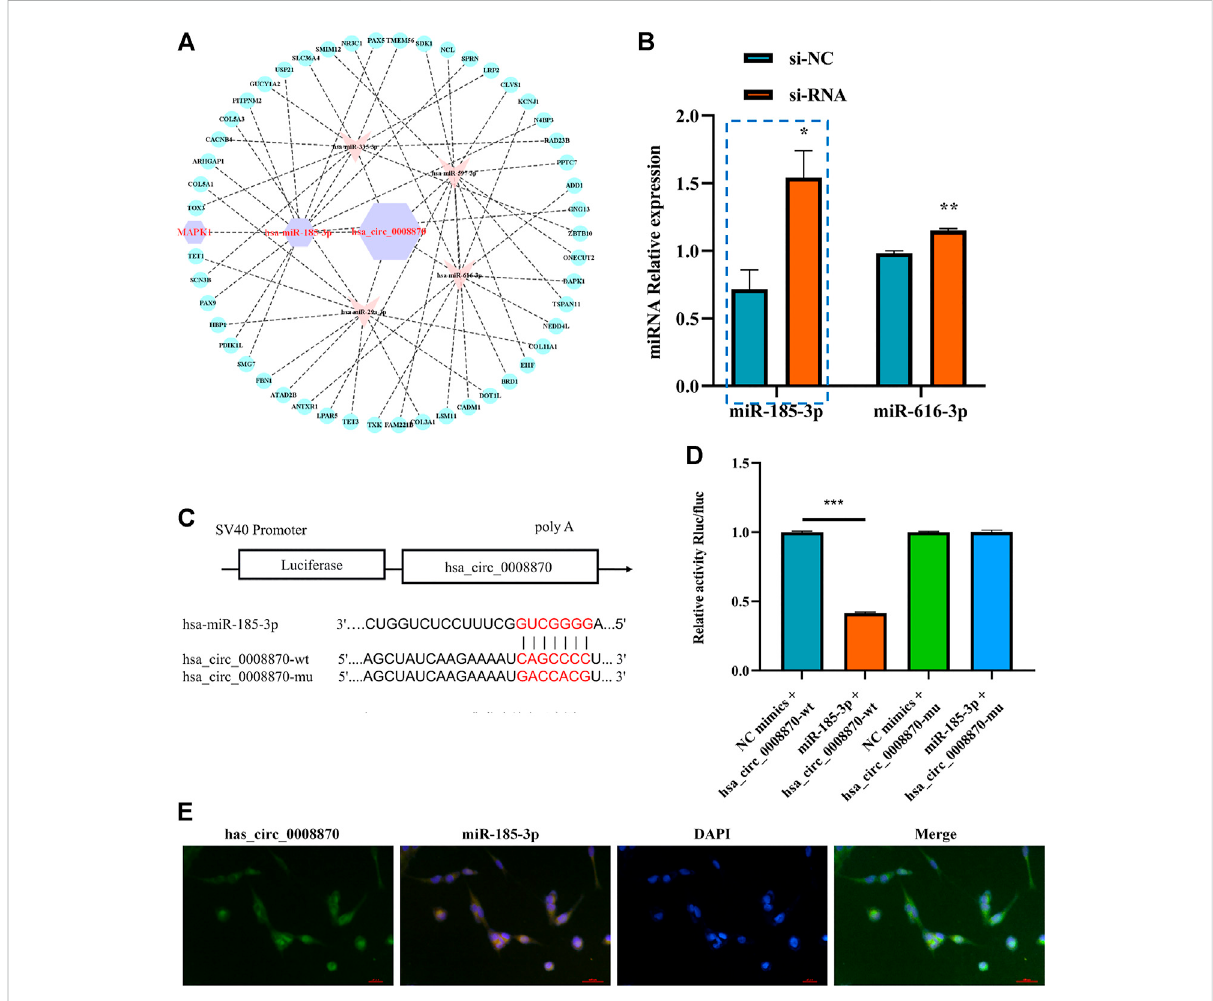
FIGURE 3 Hsa_circ_0008870 acted as an miR-185-3p sponge. (A) hsa_circ_0008870 targeted miRNAs-mRNAs network prediction. (B) The expression of predicted miRNAs in chondrocytes following downregulation of hsa_circ_0008870 expression. (C) The potential target binding sites between hsa_circ_0008870 and miR-185-3p. (D) Luciferase activity was repressed in human chondrocyte cotransfected with WT hsa_circ_0008870 and miR-185-3p mimics, while it was restored in cells cotransfected with Mut hsa_circ_0008870 and miR-185-3p mimics. (E) Fluorescence in situ hybridizationprovedtheco-localizationofhsa_circ_0008870andmiR-185-3pinhumanchondrocytesandmousefemoralgrowthplates.P > 0.05; *, p < 0.05; **, p < 0.01; ***, p < 0.001; ****, p <